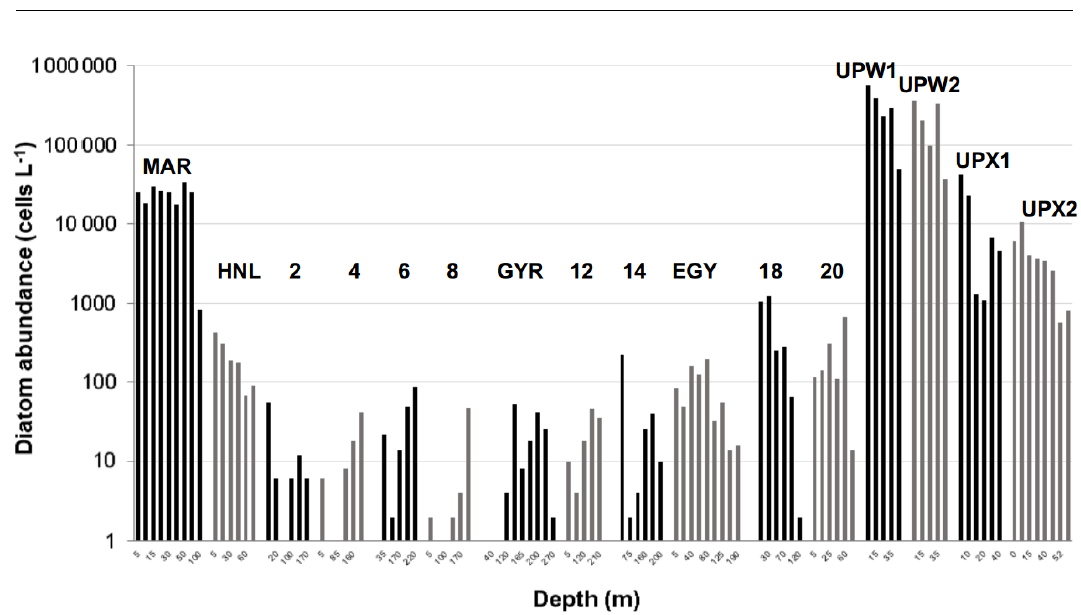
Figure 10. Diatom cellular concentrations (cellsL − 1 ) derived from Niskin cell counts at several depths during the BIOSOPE cruise (data from Gomez et al.,